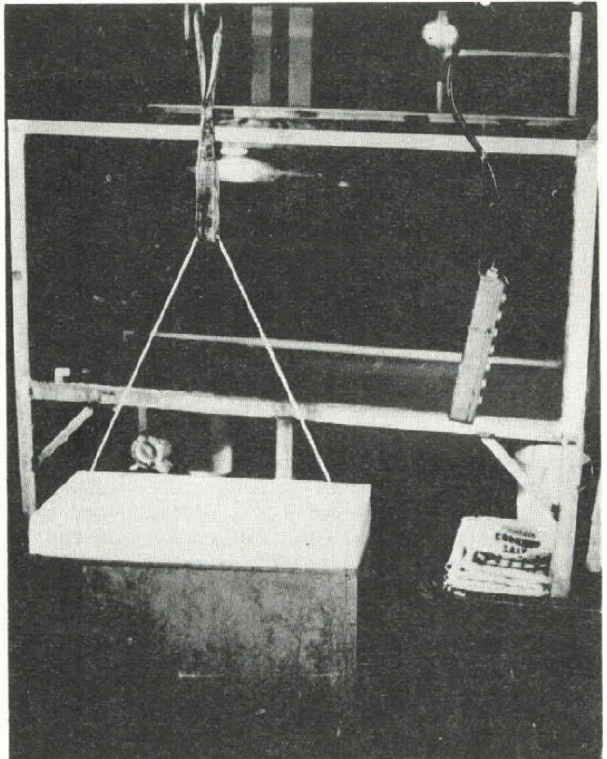
Figure 4. Photograph of the ice block suspended via a rope frozen into the ice and the salt-water tank in the background; figure reproduced from [109], with permission from Cambridge University Press,